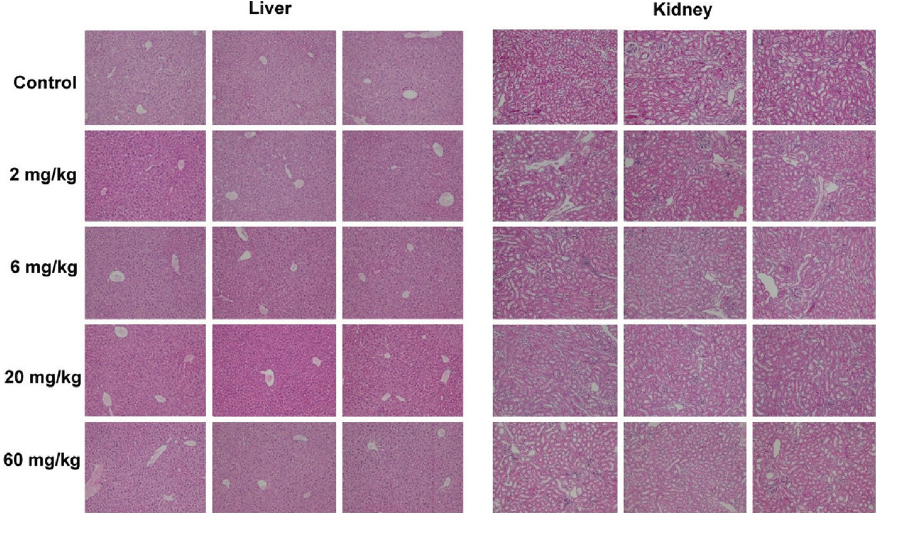
Figure 20. Liver and kidney histological pictures from mice treated with vehicle or YD0171. Mice were subjected to intraperitoneal injection of YD0171 in two divided doses (total daily doses: 2, 6, 20 and 60 mg/kg/d) for five consequent days. On the morning of the sixth day, animals were killed and tissues subjected to H&E staining and histological anal- ysis. From each group, sections from three randomly selected animals are